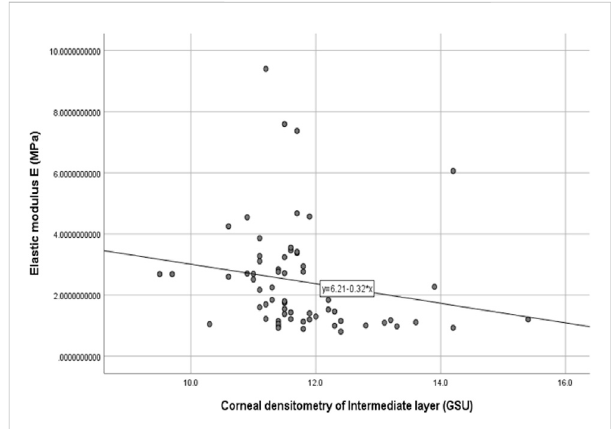
FIGURE 1 Correlation between the corneal densitometry of intermediate layer and Elastic modulus E (R = − 0.35, p = 0.01).